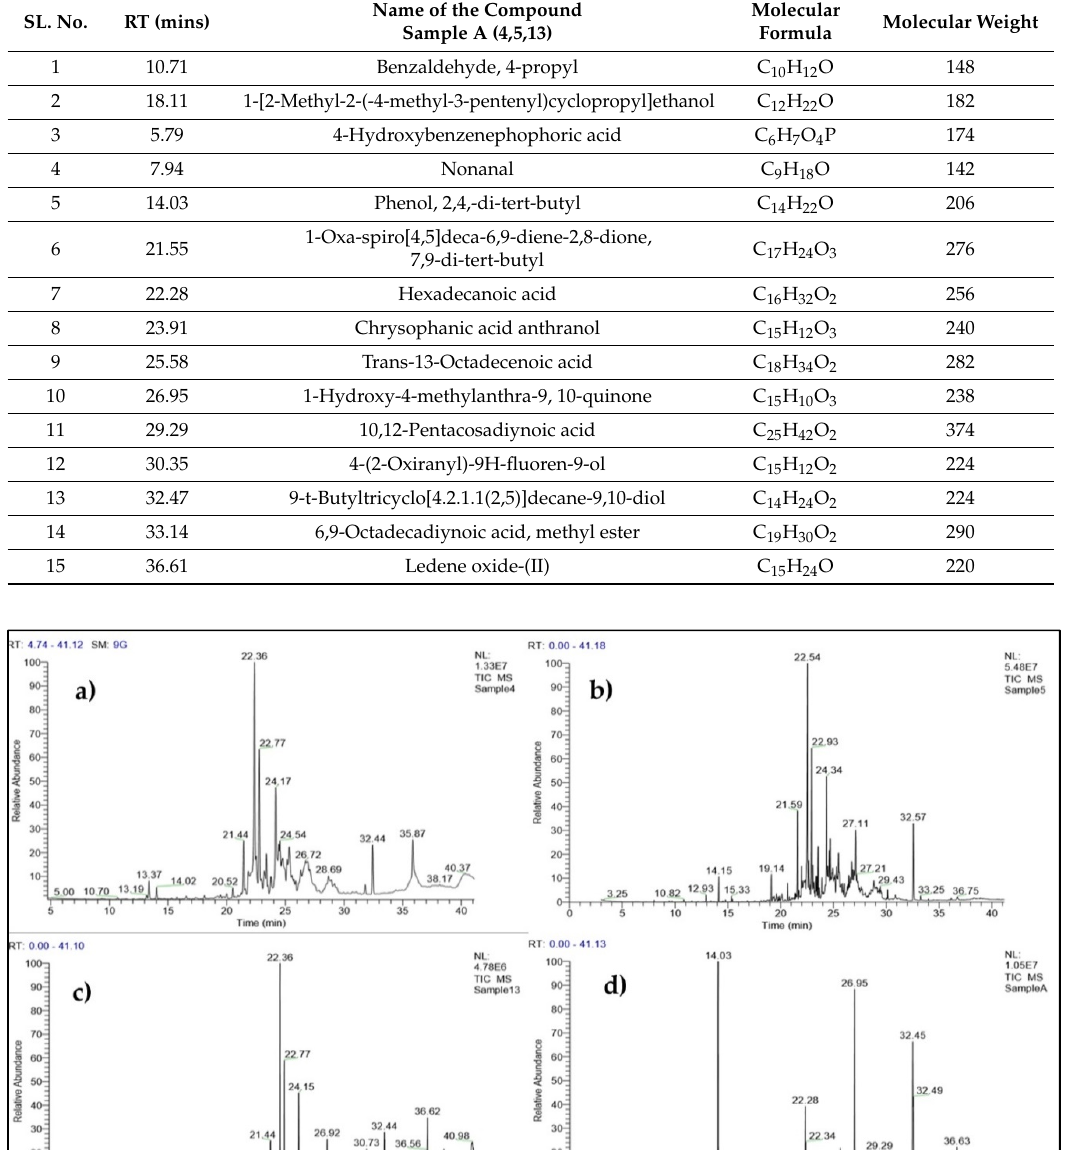
Table 5. List of compounds of Trichoderma spp. co-culture (PGTA) detected by GC-MS.